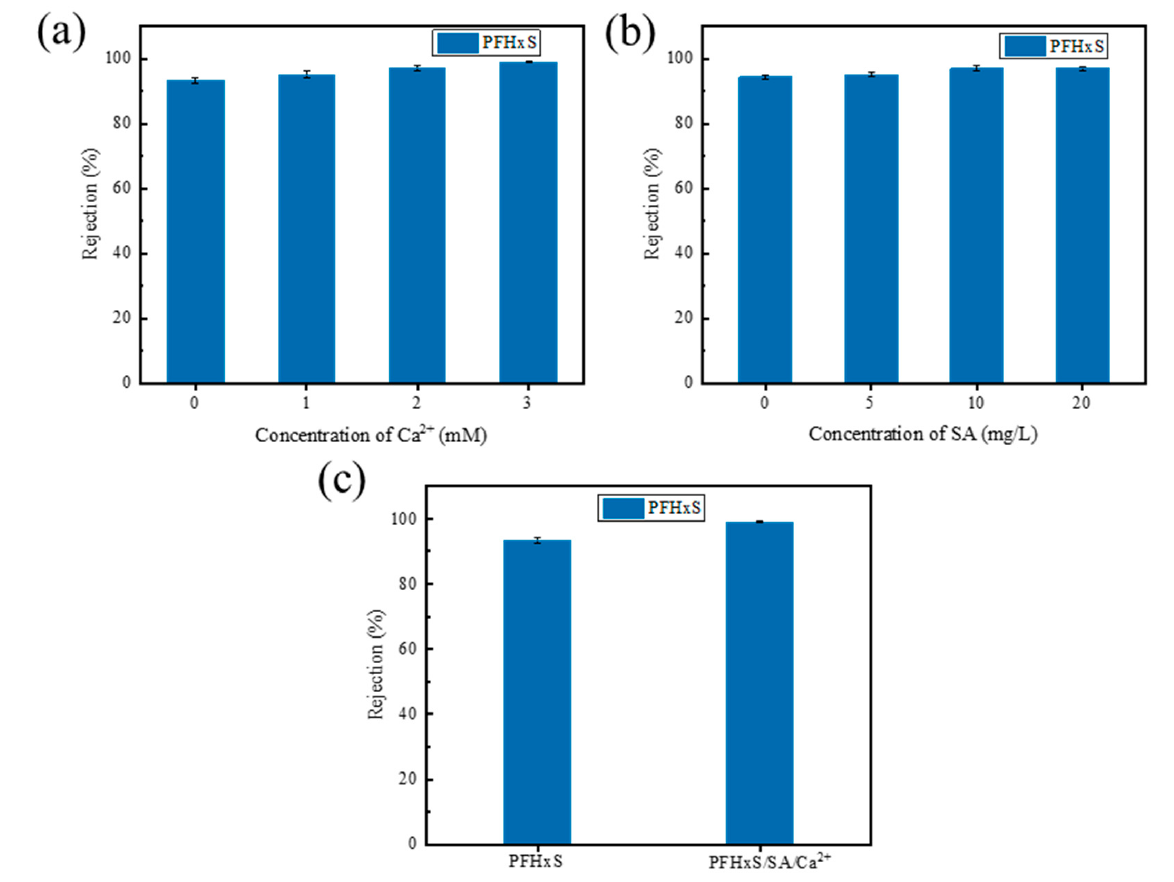
Figure 2. Effect of ( a ) the concentration of Ca 2+ , ( b ) the concentration of SA, and ( c ) the coexistence of Ca 2+ and SA on the removal of PFHxS by HA-TFC i NFM.